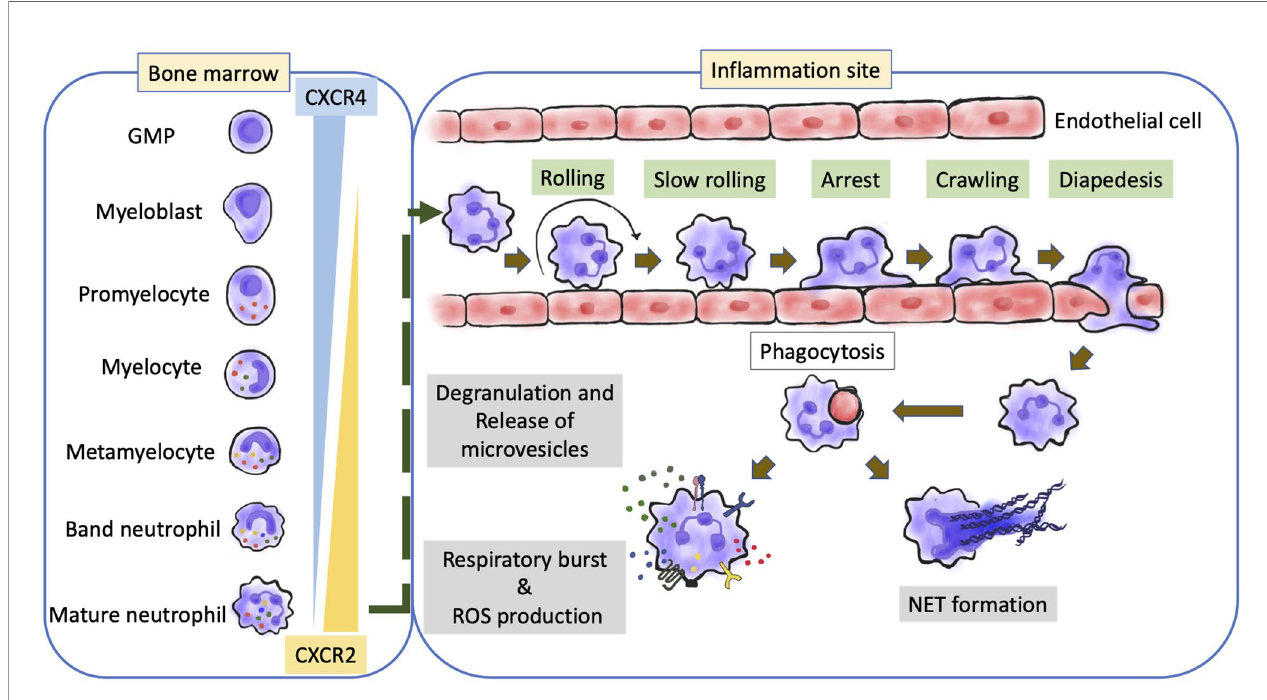
FIGURE 1 | Overview of neutrophil development and biological function. The production and maturation of neutrophils develop in bone marrow. After stress or in fl ammatory stimulation, neutrophils undergo a special recruitment cascade and eventually migrate into in fl ammatory tissues. Respiratory burst, degranulation, and NETs formation are the main mechanisms responsible for in fl ammation, leading to the elimination of the invading microorganisms or promoting the in fl ammatory response; CXCR, CXC-chemokine receptor; GMP, granulo-monocytic progenitor; NETs, neutrophil extracellular